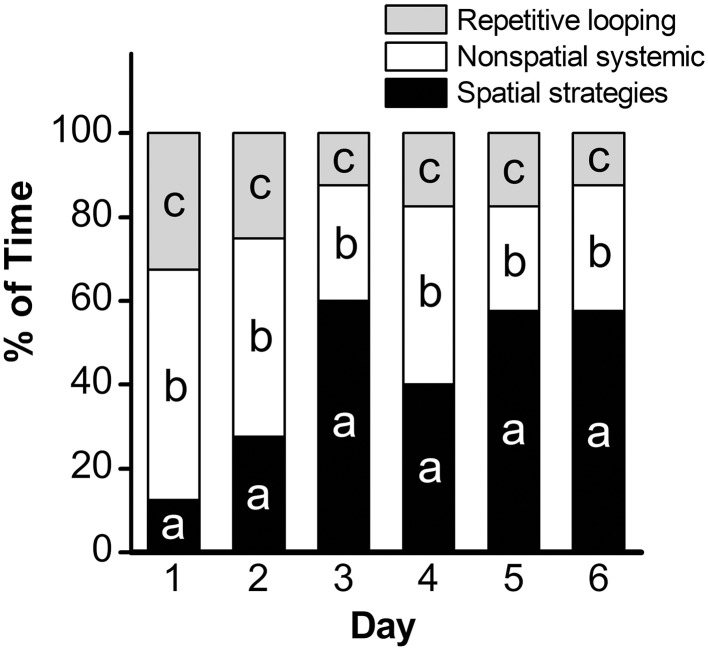
Assessment of search strategy in the acquisition phase of the MWM. The percentage of time engaged in specific search strategies during the 60-s trial was calculated, with search strategies combined into 3 groups based on functional similarity (repetitive looping, nonspatial systemic strategies, and spatial strategies) and analyzed using Chi Square. a: p < 0.001; b: p = 0.001; c: p = 0.02. n = 10.